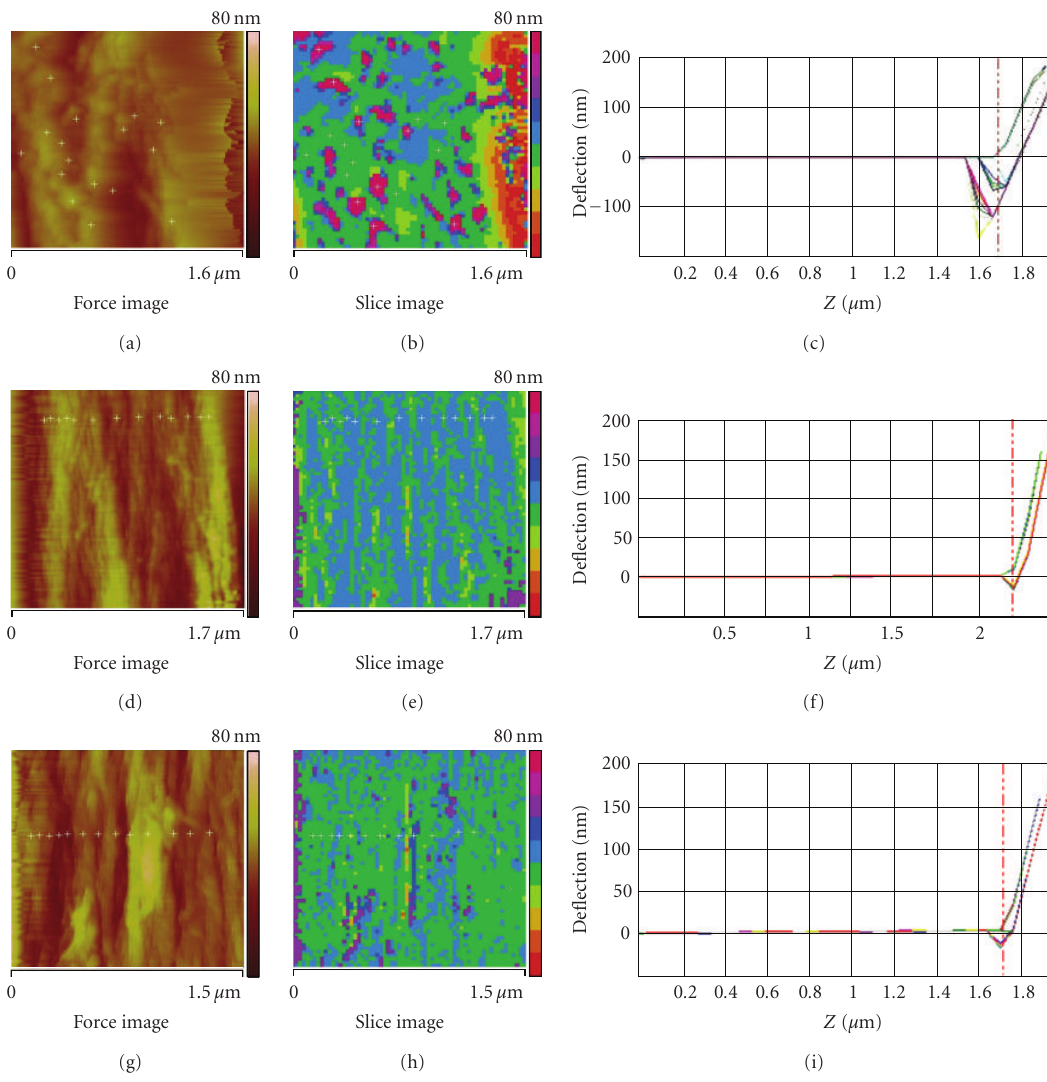
Figure 7: AFM Force-volume images: topography, FV adhesion force map, and force plots corresponding to raw flax fibres ((a), (b), and (c), resp.); NaOH-treated fibres ((d), (e), and (f), resp.); enzyme-treated flax ((g), (h), and (i),